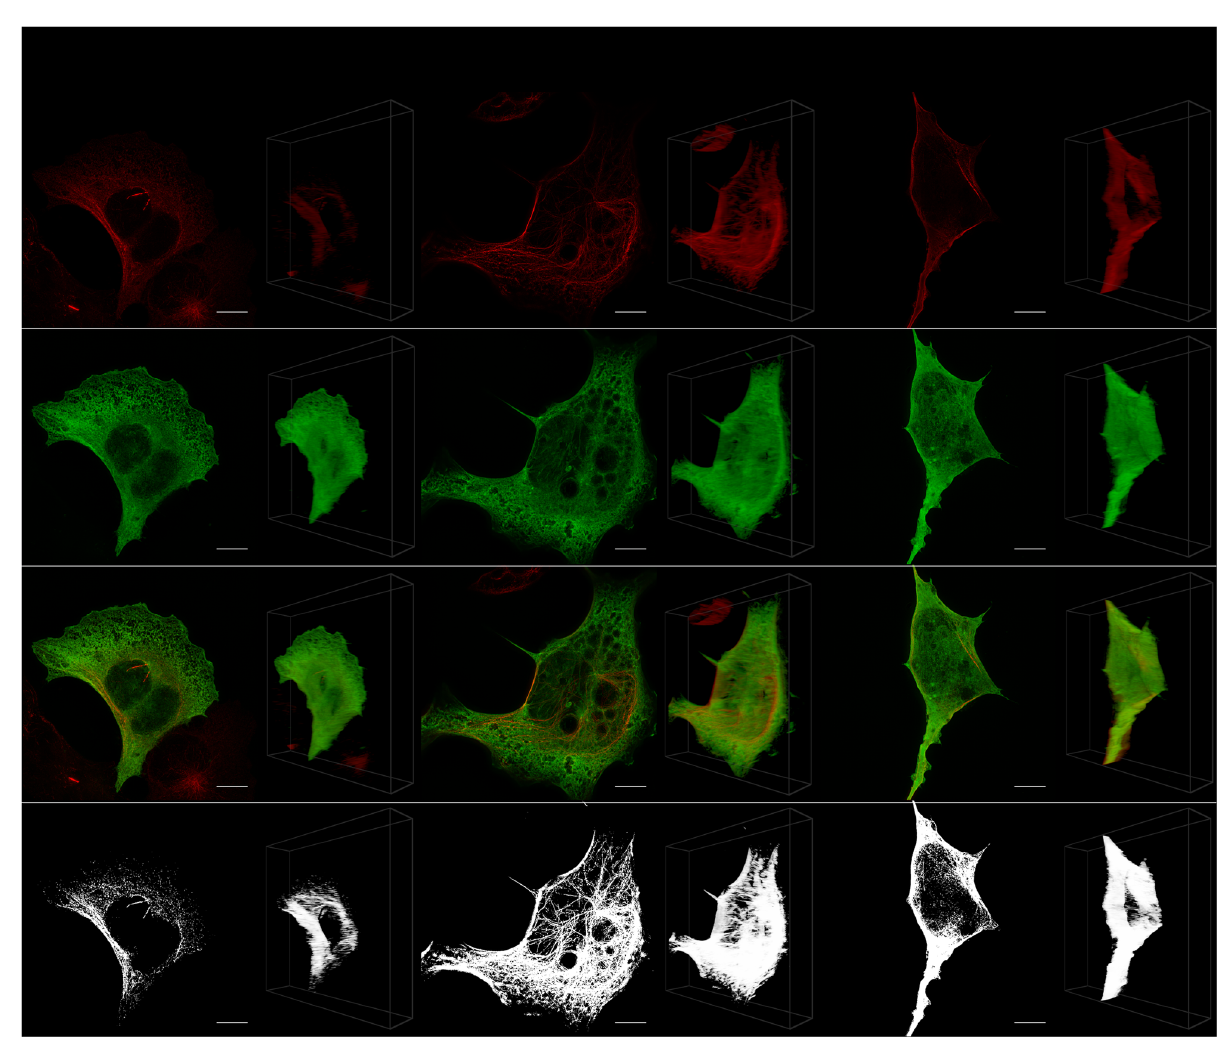
Fig 3. Whole cell. Representative cells for each considered time ( t = 0, t = 6, t = 24) with the maximum intensity projection on the left and the 45˚ 3D view on the right. Shown from top to bottom are the acetylated α -tubulin (red), the Tau (green), the tubulin and Tau overlaid, and only the colocalized